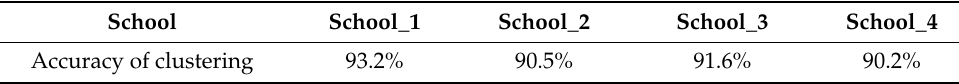
Table 4. The accuracy of the clustering results of each school.